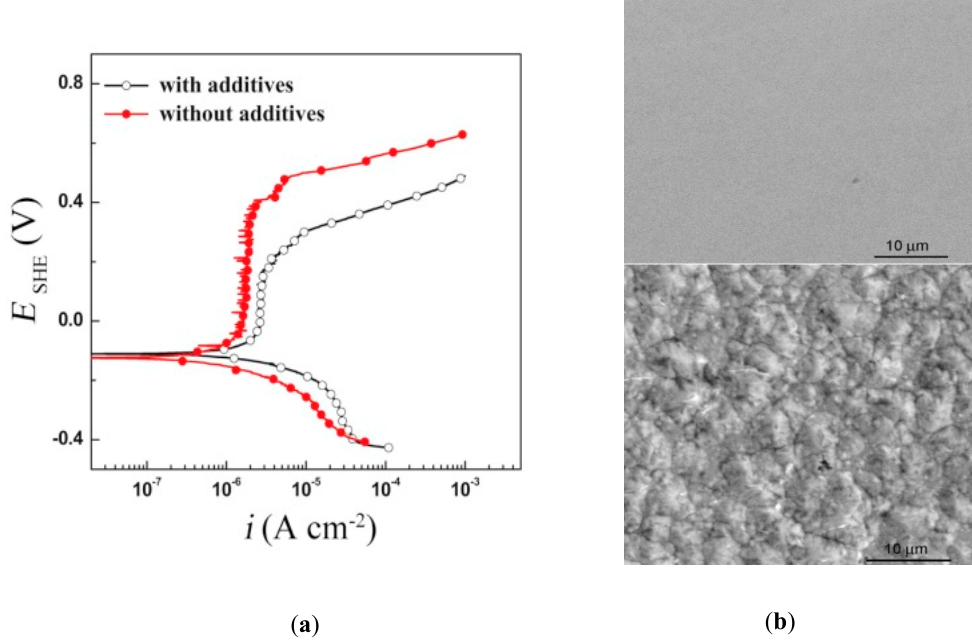
Figure 10. Effect of additive. ( a ) Potentiodynamic polarisation curves of nanocrystalline nickel coatings synthesised with (saccharin and 2-butyne-1,4-diol) and without the additive; ( b ) Surface morphology of nickel coatings synthesised from the bath: ( a ) with additives, ( b ) without additives [59].